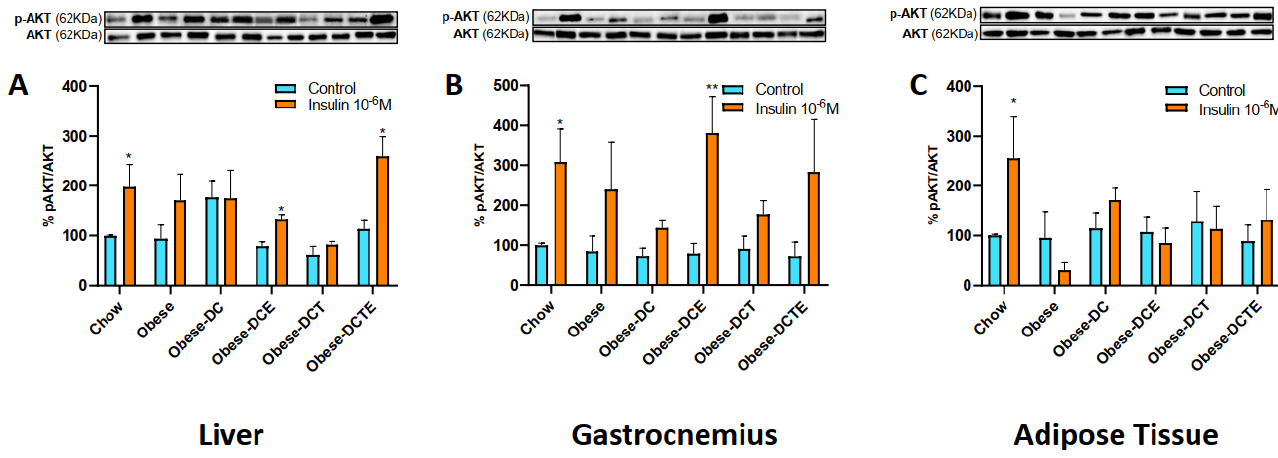
Figure 2. p-Akt/Akt ratio in explants of liver ( A ), gastrocnemius ( B ) and adipose tissue ( C ) incubated in the presence/absence of insulin (10–6M). Chow = mice fed a standard diet for 25 weeks; Obese = mice fed a high fat (60% kcal from fat)/high sucrose diet for 25 weeks; DC = mice fed a high fat (60% kcal from fat)/high sucrose diet for 23 weeks and switched to a diet with lower caloric intake (25% kcal from fat) for two weeks; DCE = mice fed a high fat (60% kcal from fat)/high sucrose diet for 23 weeks and switched to a diet with lower caloric intake (25% kcal from fat) supplemented with CSAT+ ® for two weeks; DCT = mice fed a high fat (60% kcal from fat)/high sucrose diet for 23 weeks and switched to a diet with lower caloric intake (25% kcal from fat) and subjected to aerobic training for two weeks; DCTE = mice fed a high fat (60% kcal from fat)/high sucrose diet for 23 weeks and switched to a diet with lower caloric intake (25% kcal from fat) supplemented with CSAT+ ® and subjected to aerobic training for two weeks. Values are represented as mean ± SEM; n = 8–10 mice/group. * p < 0.05 vs. control; ** p < 0.01 vs. control.